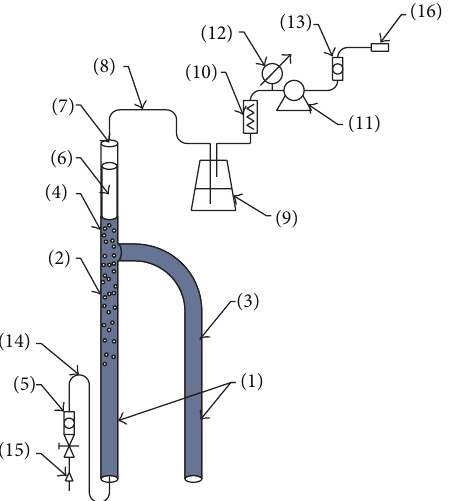
Figure 1: The scheme of the novel gas desorber.